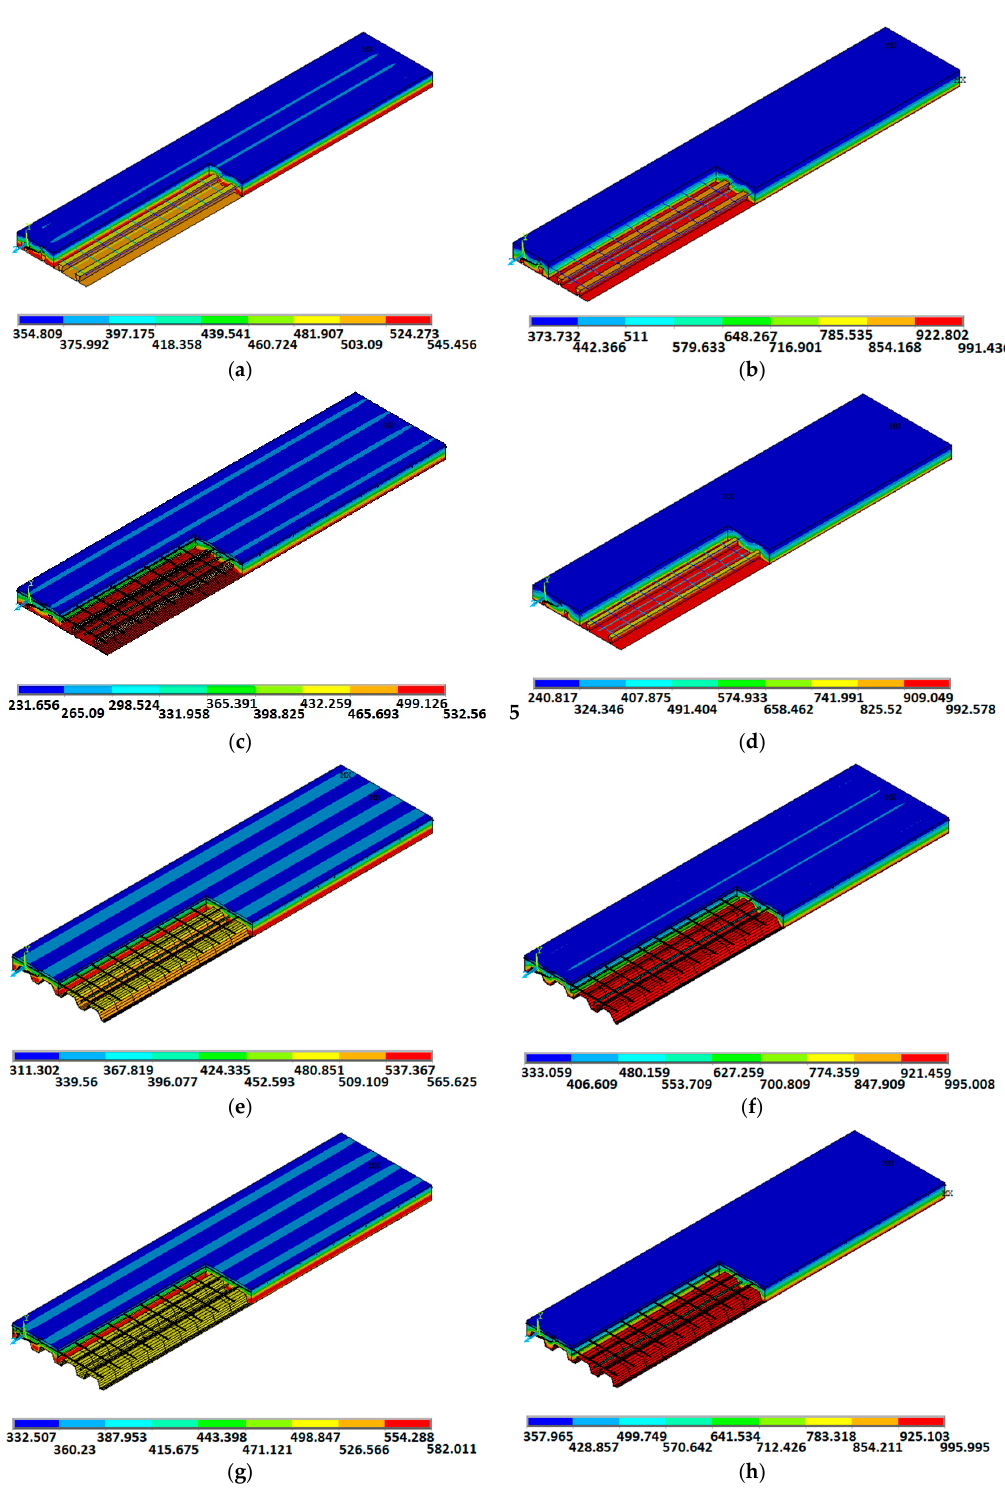
Figure 7. Temperature field over the composite slabs under parametric fire curves for the same h 1 = 60 mm and for time equal to 100 min: ( a ) Multideck 50 under parametric fire 2; ( b ) Multideck 50 under parametric fire 3; ( c ) Bondeck under parametric fire 2; ( d ) Bondeck under parametric fire 3; ( e ) Polideck 59S under parametric fire 2; ( f ) Polideck 59S under parametric fire 3; ( g ) Confraplus 60 under parametric fire 2; ( h ) Confraplus 60 under parametric fire 3.